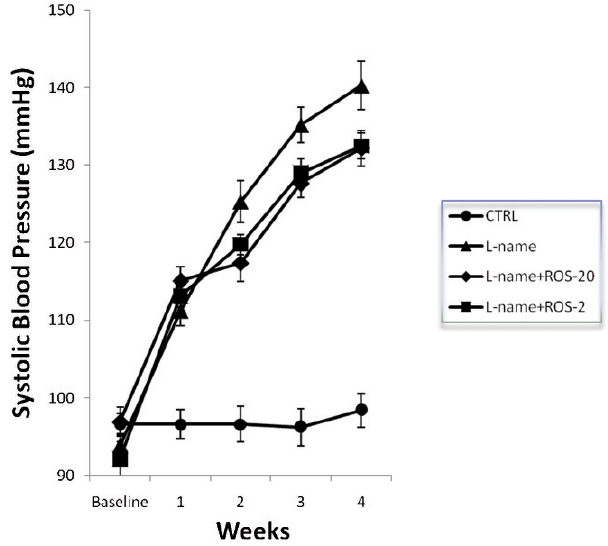
Figure 1 - Systolic blood pressure over the entire experimental period in control and treated rats. The data are expressed as the mean ¡ SEM for =10 rats/group. After the first week, all of the treated groups (L-name, L-name + ROS-20, L-name + ROS-2) had significantly increased systolic blood pressures when compared with the CTRL group ( p ,